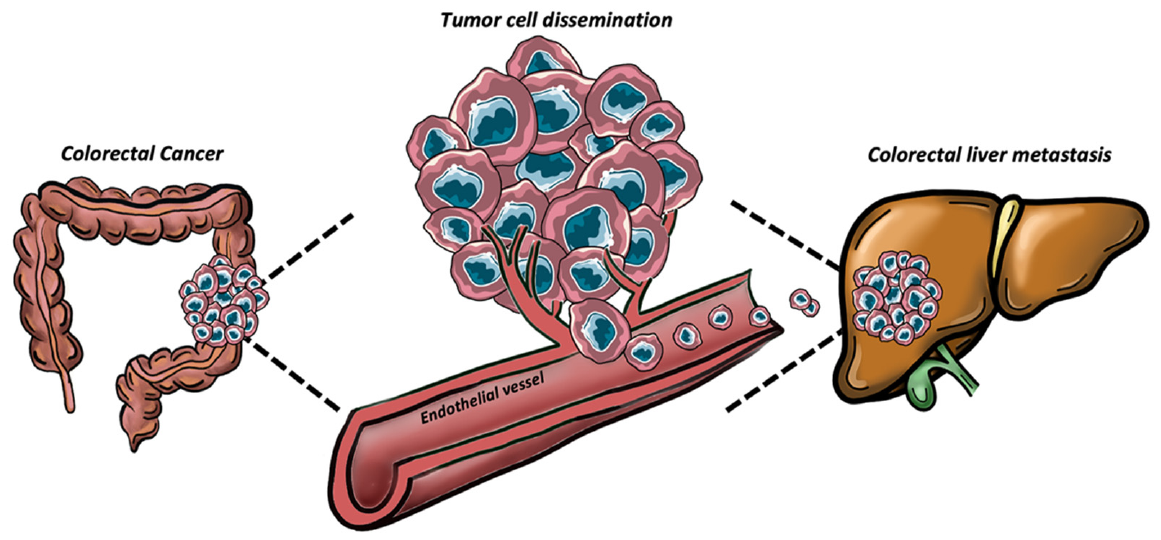
Figure 1. Representative image of the tumor cell dissemination process from the primary site (colon) to the metastatic one (liver).